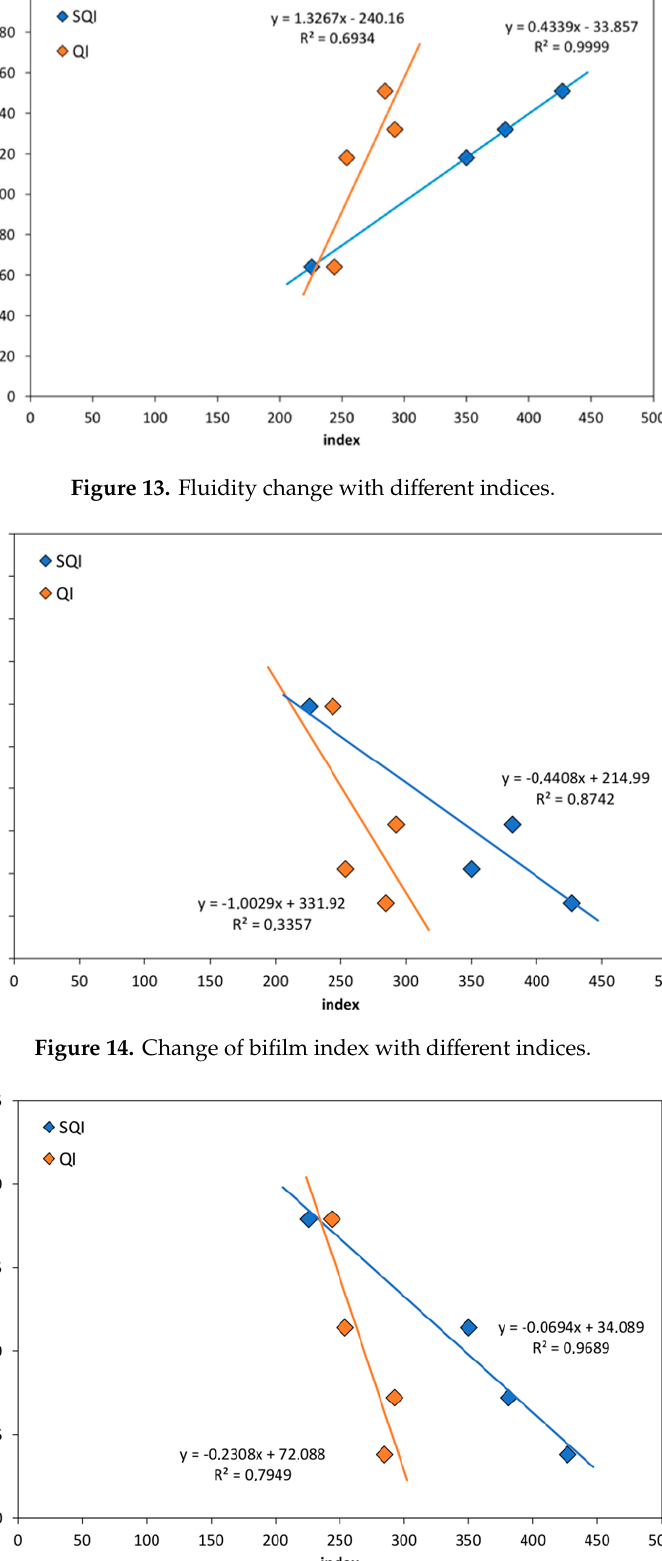
Figure 15. Change of rejection rate with di ff erent